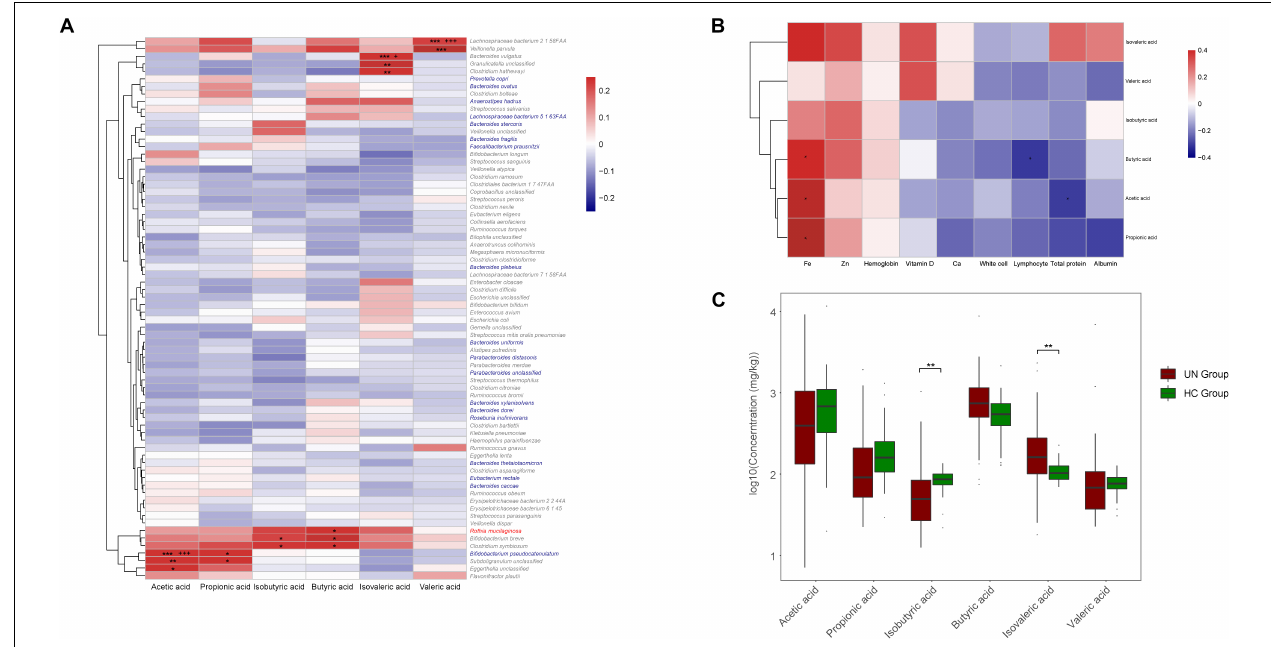
FIGURE 5 | Correlations among GM, SCFAs, and nutritional indicators. (A) The positive and negative relationships between GM and SCFAs are exhibited with red and blue boxes, respectively. Significant relationships are indicated with “ ∗ ” or “ + .” ∗ P < 0.05, ∗∗ P < 0.01, ∗∗∗ P < 0.001, +FDR < 0.05, and + + + FDR < 0.001. Species labeled in red or blue were enriched in the UN or HC groups, and, for species labeled in gray, no significant differences were observed between these two groups. (B) The relationships between SCFAs and nutritional indicators were also explored. Red and blue boxes stand for positive and negative relationships, respectively, and ∗ P < 0.05. (C) Comparison between the concentrations of SCFAs of the UN and HC groups. ∗∗ P < 0.01.